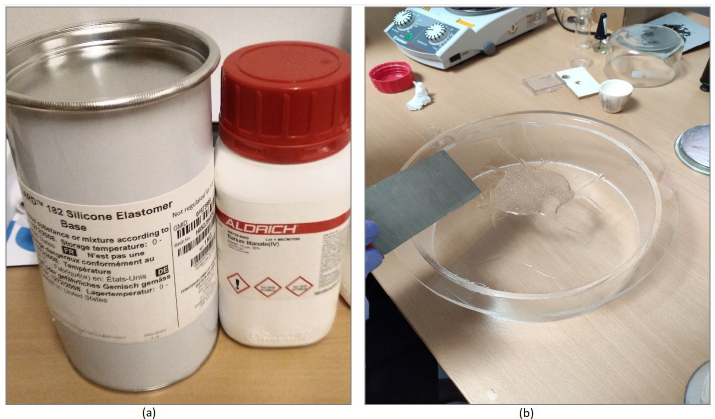
Figure 3. Photos of the experimental procedure: ( a ) the materials used to make the composite, and ( b ) snapshot of the mixing process.